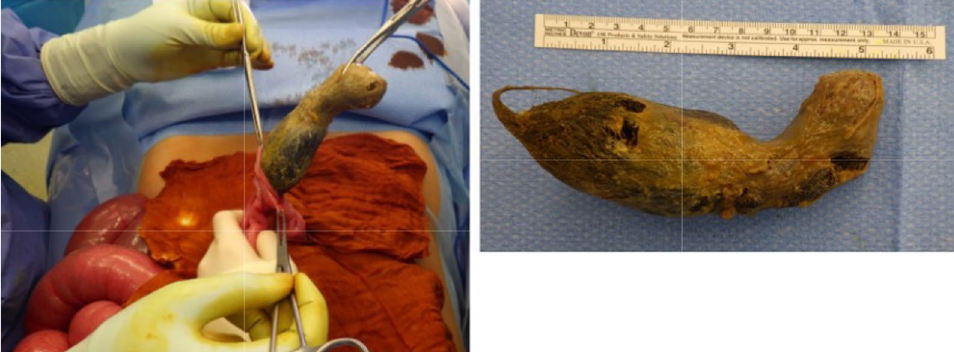
Fig. 5 A smaller trichobezoar with a tail was surgically removed en bloc by an upper median laparotomy and ileotomy (added ruler equals 15